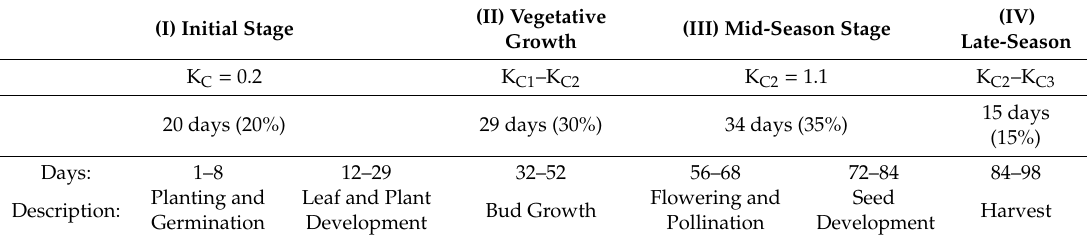
Figure 3. ( a ) Crop coefficients for the different growing stages. ( b ) Estimated daily (solid blue) and weekly (orange dashed line) evapotranspiration (ET C ) (mm) during the growing season. Table 2. Description of crop development across the different growth stages.